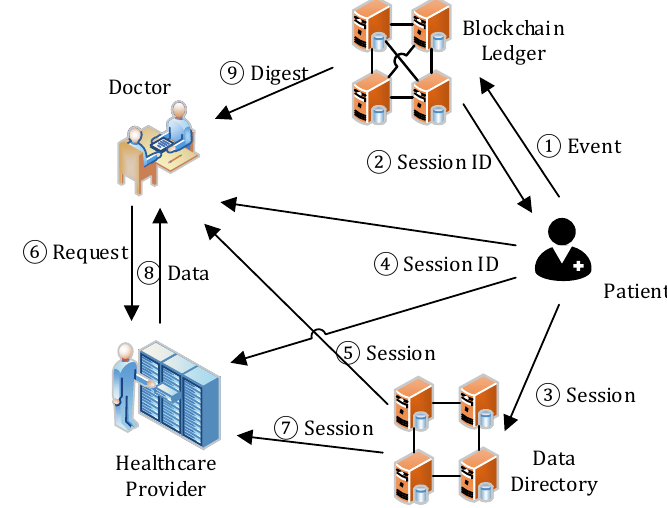
Figure 6. Process of session ‐ based data sharing.